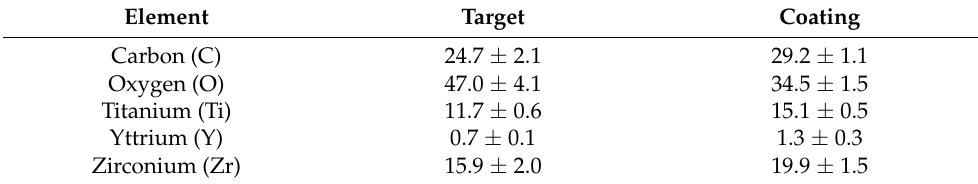
Table 6. Atomic composition (as a percentage) of the 3YSZ-TiC target material and